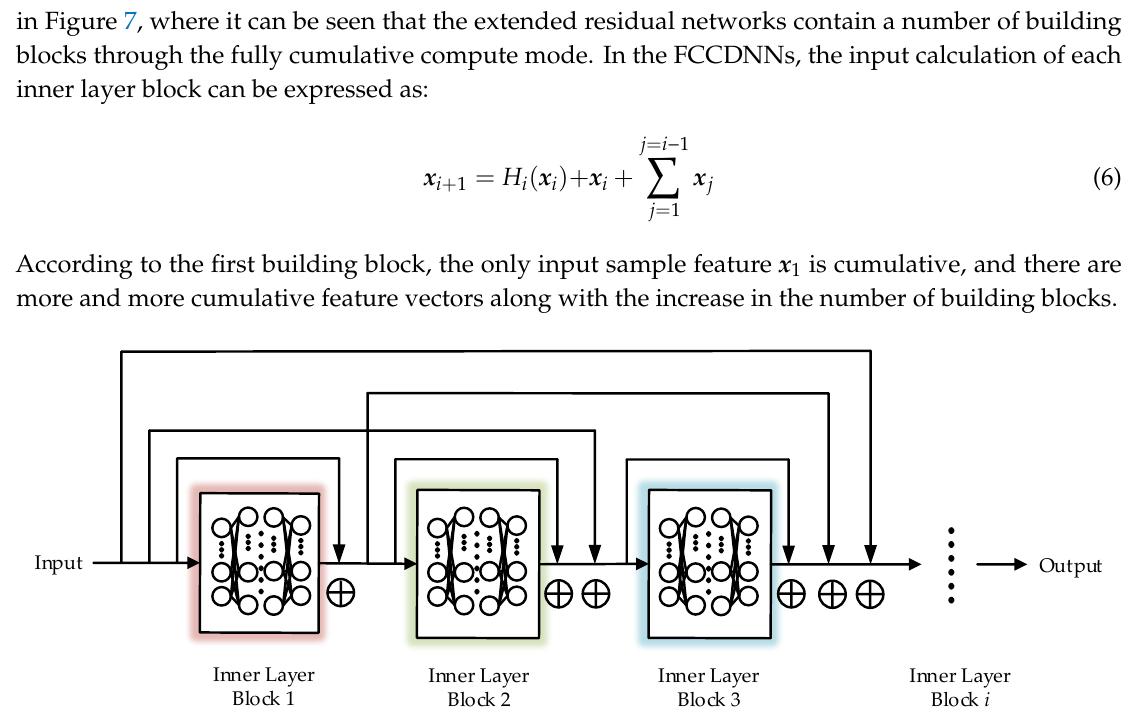
Figure 8. The neuronal morphology classification process based on the LCCDNNs. The neuron morphology classification process based on the LCCDNNs is shown in Figure 8. The neuron classification process consisted of the following parts: first, the selected neuronal dataset was divided into training and test sets, then the feature values were extracted by using the L-Measure tool; second, the normalized feature values were also obtained by feature scaling with Equation (7);